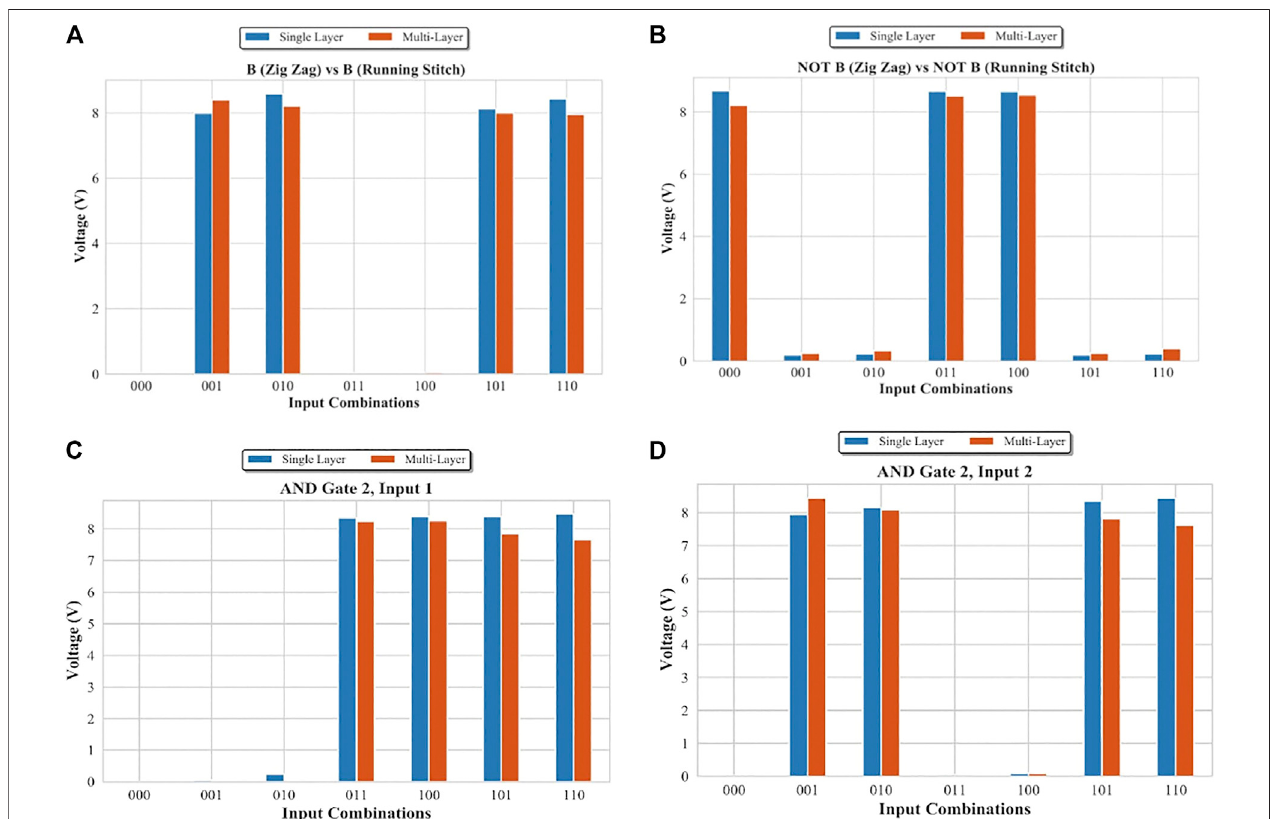
FIGURE 9 | Graphs representing the voltage output reading coming from the input/NOT logic gate connectors and embroidered AND logic gate number 2 input voltage readings: (A) comparison of voltage readings from the B input connector, (B) comparison of voltage readings from the NOT B input connector, (C) AND gate 2, input 1 voltage readings, and (D) AND gate 2, input 2 voltage